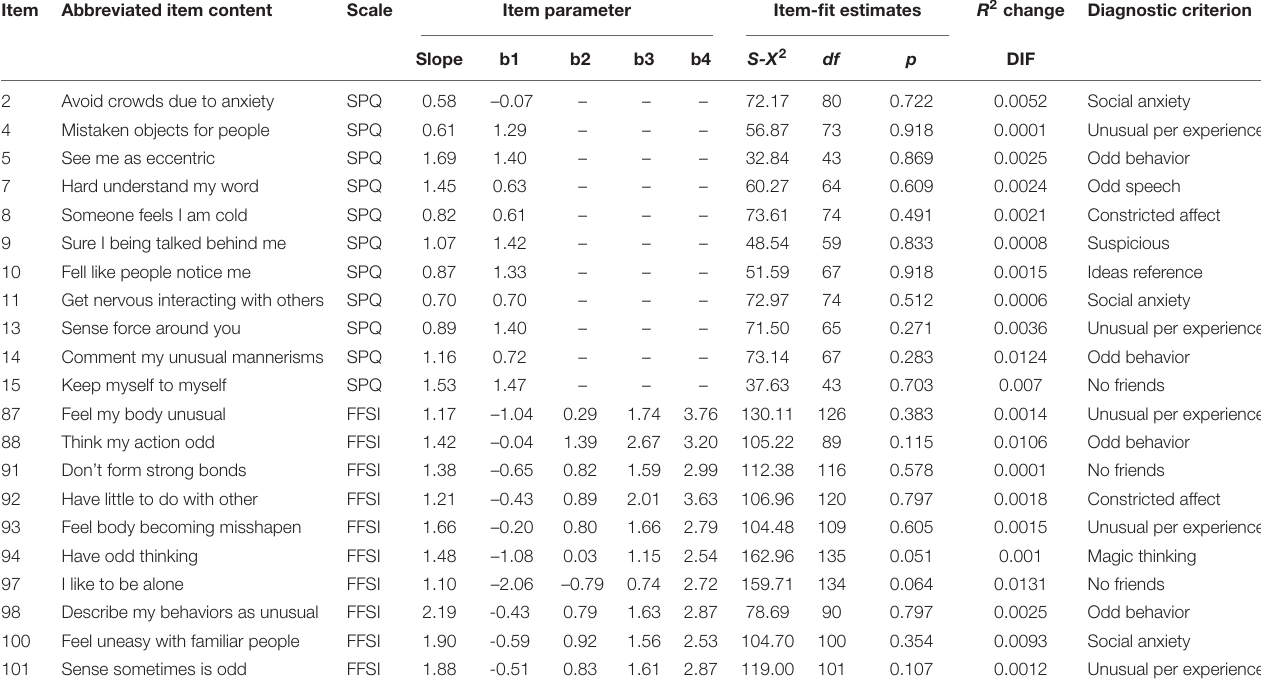
TABLE 3 | IRT statistics of part item in the final item pool of the